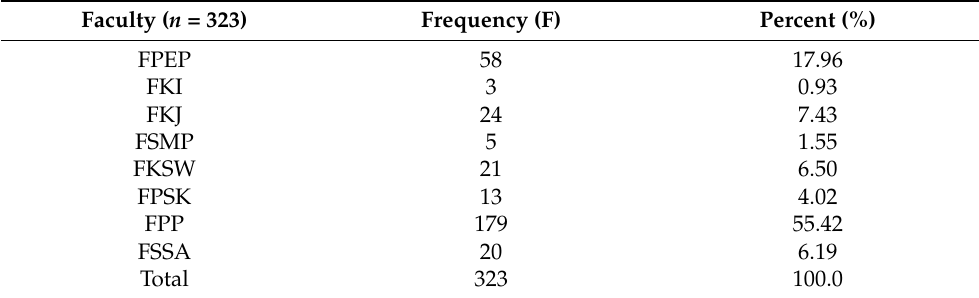
Table 3. Frequency and percentage of respondent faculty.